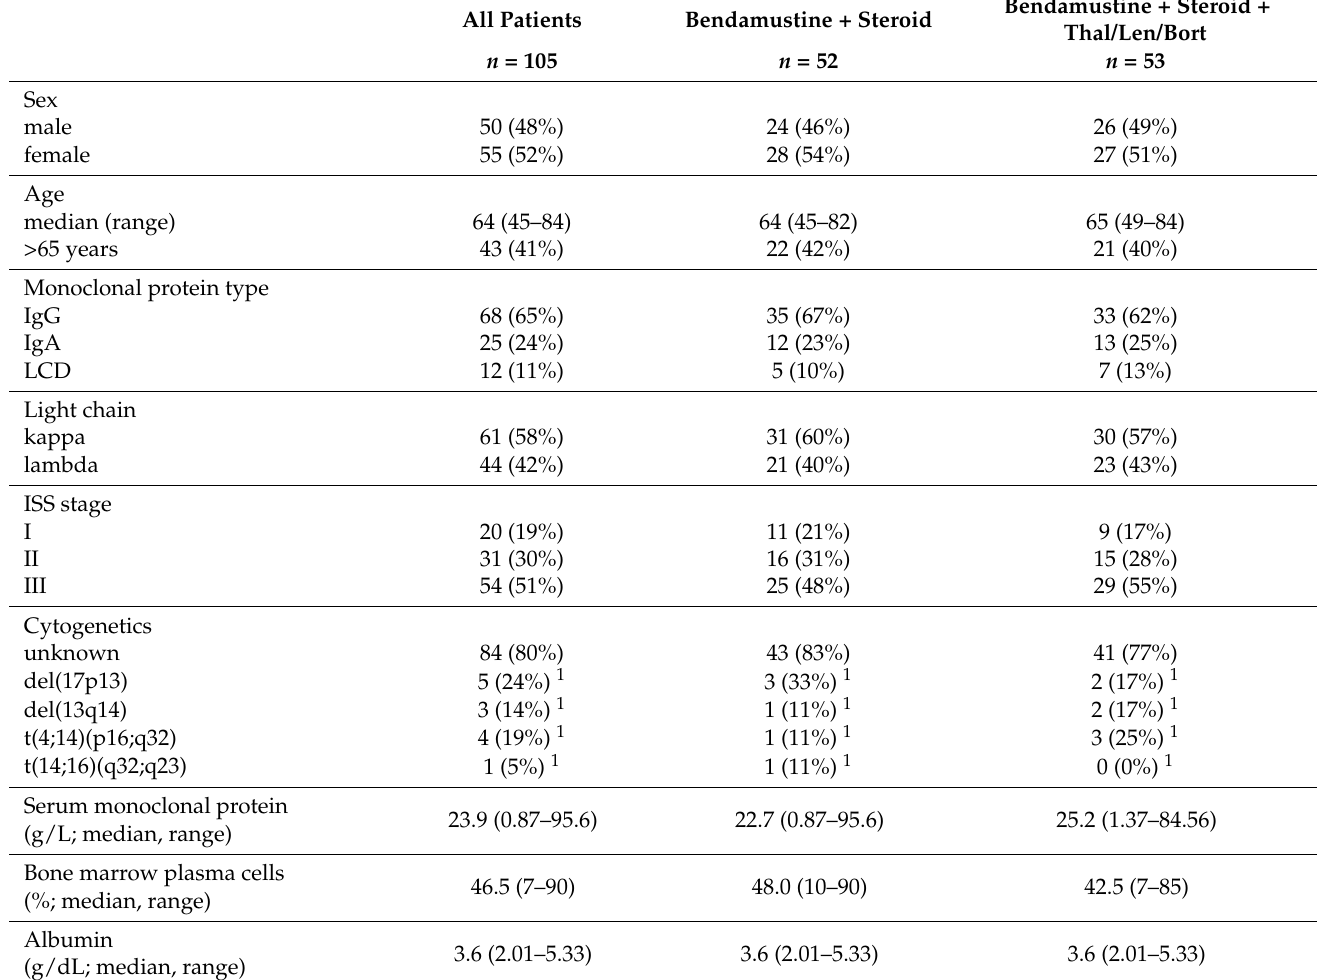
Table 1. Patient